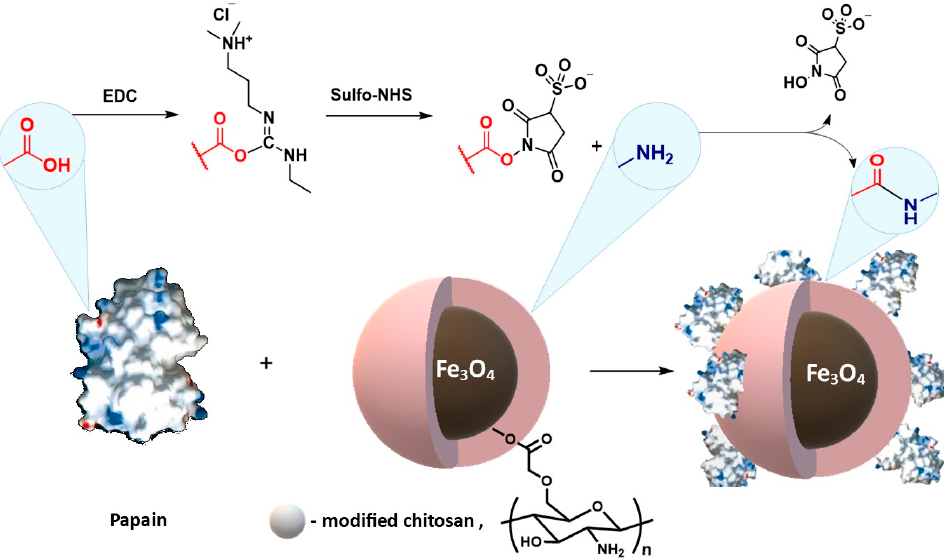
Figure 15. Schematic illustration for the surface modification of Fe 3 O 4 magnetic nanoparticles by carboxymethylated chitosan and subsequent conjugation with papain.